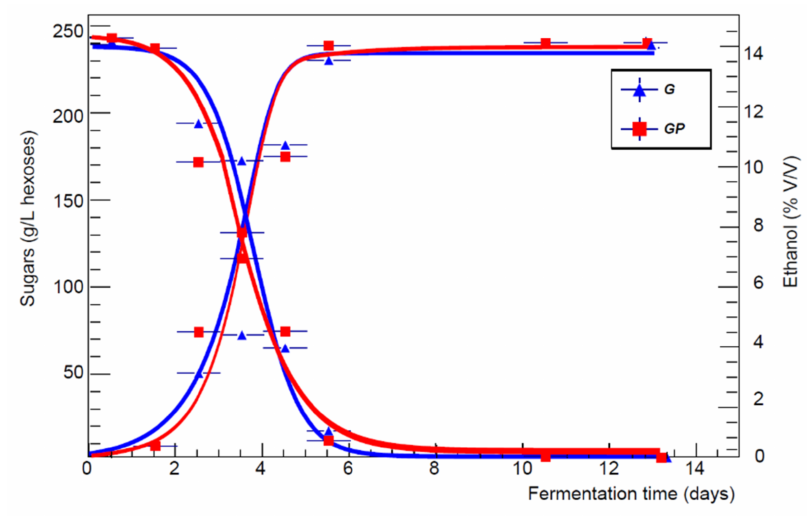
Figure 1. The kinetics of sugars consumption and ethanol production as a function of the fermentation time (days) for the three vineyards.